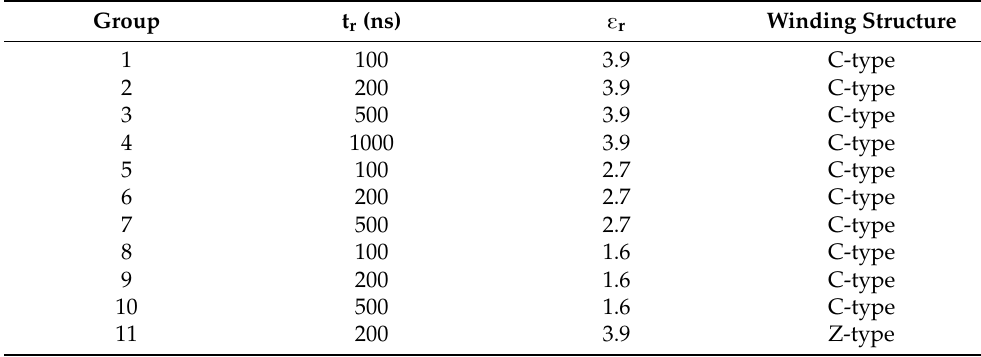
Table 5. Detailed parameters of the simulation on the complete